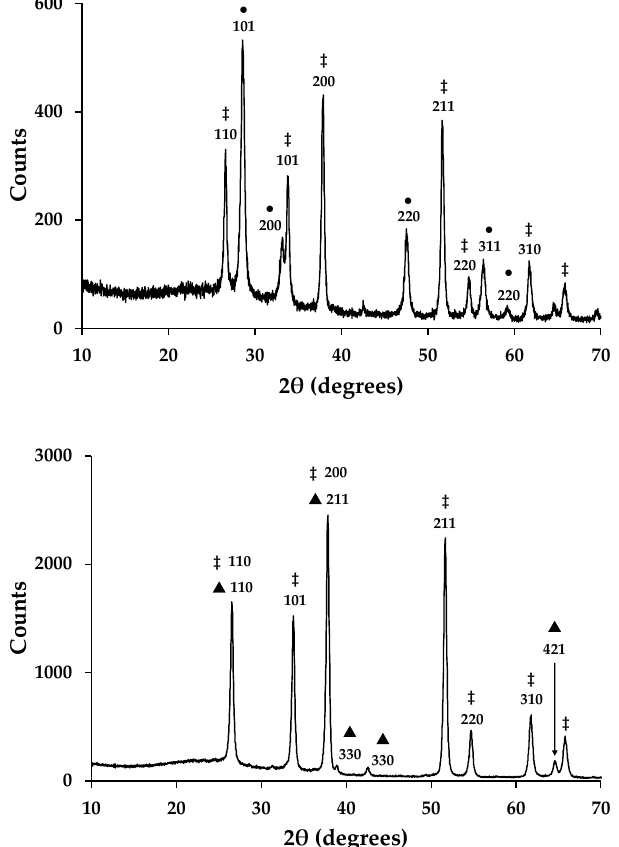
Figure 2. X-ray powder di ff raction data for mesoporous films of (top) CeO 2 and (bottom) MnO 2 Figure 2. X ‐ ray powder diffraction data for mesoporous films of (top) CeO 2 and (bottom) MnO 2 showing indexed diffraction peaks. Key: ‡ = SnO 2 , ● = CeO 2 , and ▲ = MnO 2 . showing indexed di ff raction peaks. Key: ‡ = SnO 2 , • = CeO 2 , and (cid:78) = MnO 2